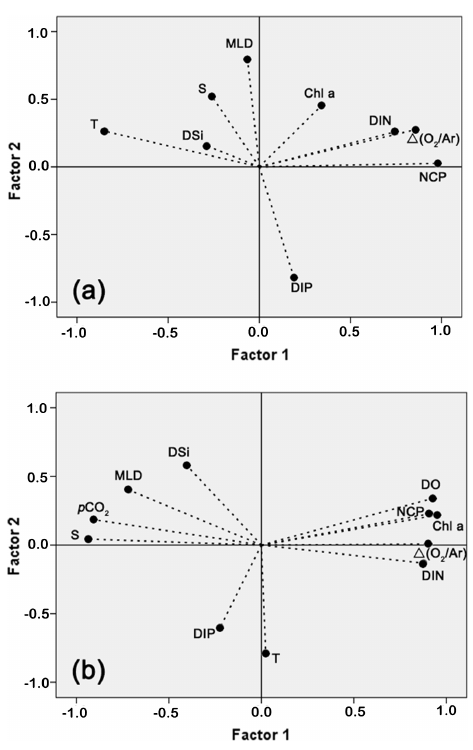
Figure 7. Principal component analysis (PCA) among variables for (a) October 2014 and (b) June 2015 (Bartlett’s test of sphericity: p < 0 . 01).